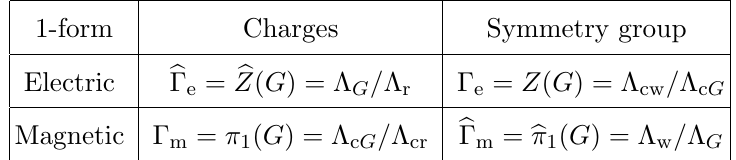
Table 1 : The relation between (cid:0) symmetries and charges of the plain G = ~ G= (cid:0) is the electric one-form symmetry group (also known as the center symmetry), and (cid:0) (cid:25) ( G ) is the group of magnetic charges carried by the ’t Hooft lines, which was denoted (cid:0) 1 in